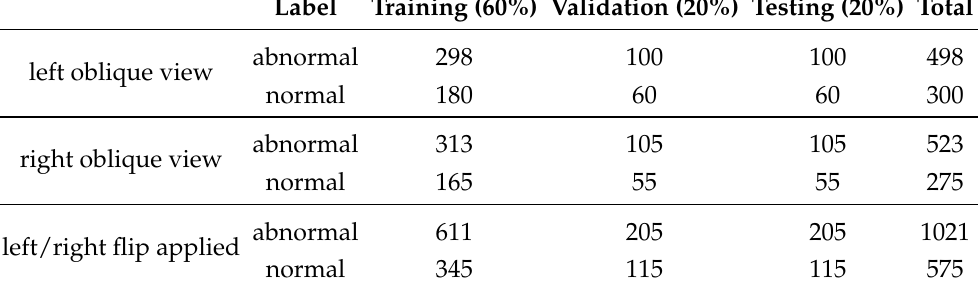
Table 2. Configuration of the cervical spine X-ray image dataset. The first and second row of the table present the configuration of the raw data before applying Flip method. The last row of the table is the configuration of the result of the Flip: flipped left view added to right view and flipped right view added to left